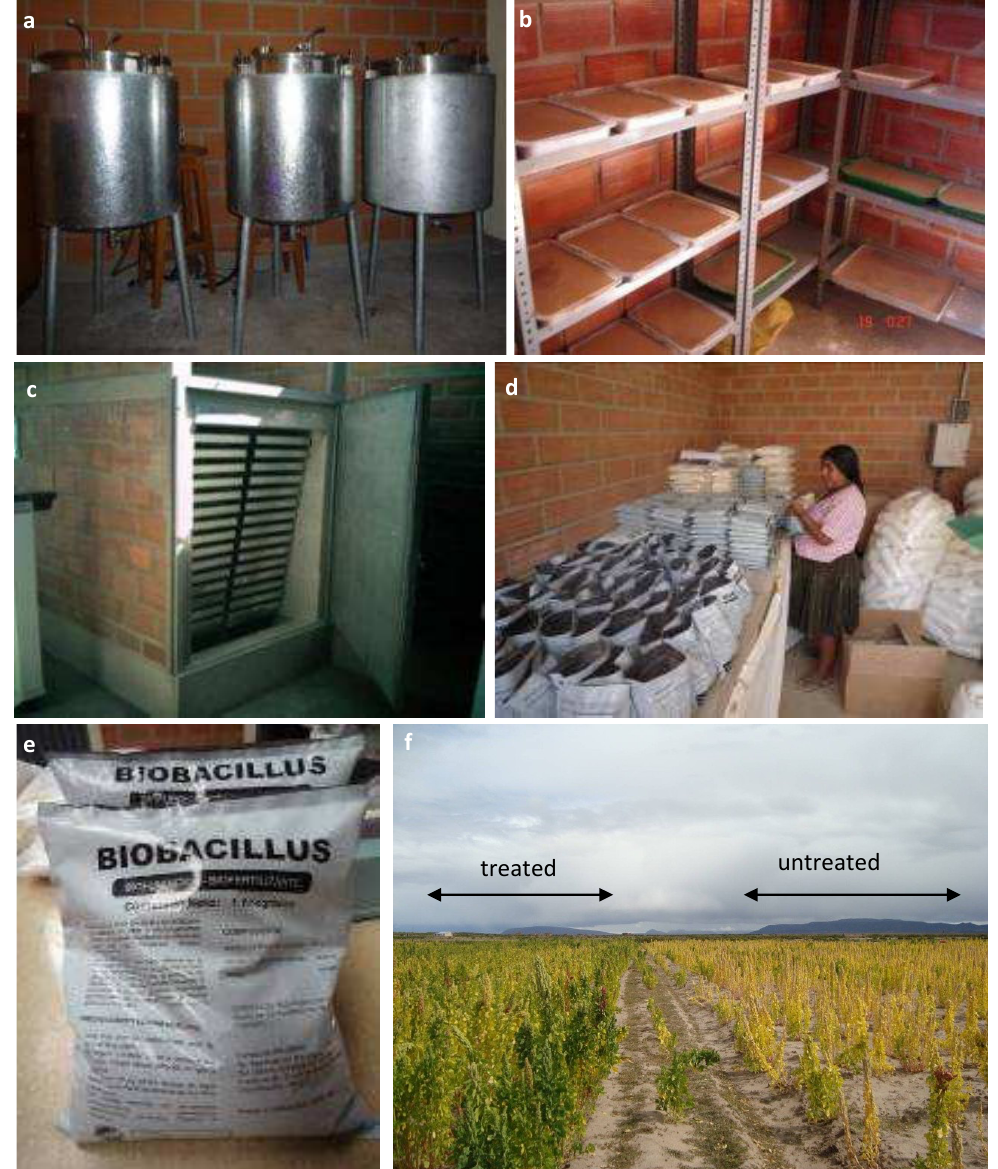
Figure 3. ( a ) Stainless steel bioreactors designed for a massive production of Bacillus subtilis spores; ( b ) Bacillus subtilis culture broth after mixing with inert material (aluminum/calcium silicate); ( c ) Dryer with forced air for the powder formulation of bacteria; ( d ) Packing of bioproducts. ( e ) Biofertilizers ready for distribution among farmers for organic production; ( f ) Organic quinoa production in the Southern Altiplano (highlands) of Bolivia: at the left quinoa, field supplemented with a bioproduct (Tricobal: B. subtilis , T. koningiopsis and T. harzianum ); at the right, control quinoa field without the use of any bioproducts.